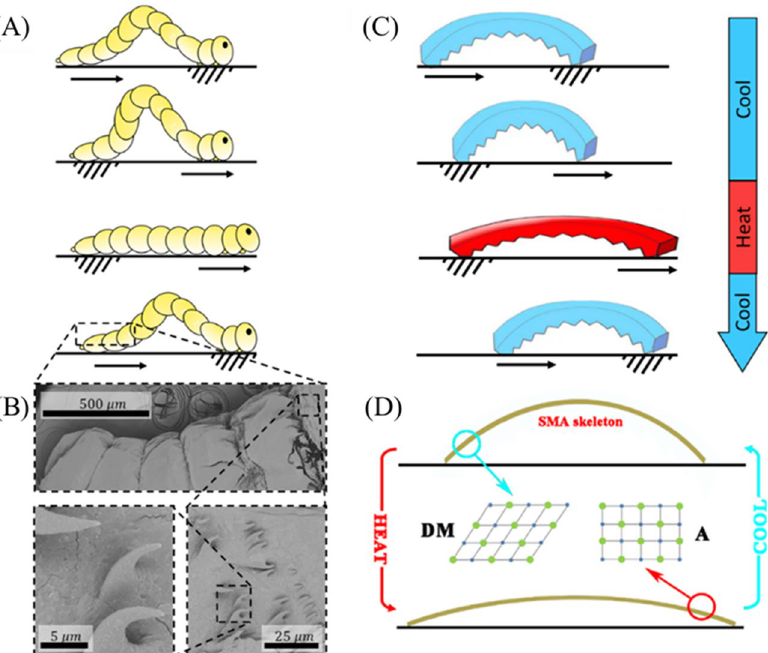
Figure 1. Schematic diagram of mag-bot. ( A ) A schematic of fruit fly larva movement displays the phases of peristaltic motion in which a larva anchors its head, pulls its tail towards its head, anchors hind portions of its body, and then pushes its head forwards. In many organisms 13,17 , such waves propagate non-harmonically along the creatures’ lengths, however—for simplicity—this is not illustrated here. ( B ) Scanning electron microscopic images of the surface microstructure of fruit fly larvae display hook-like features that give rise to asymmetric friction. ( C ) A schematic of ideal, bio-inspired mag-bot motion is displayed under a cycle of heating and cooling. ( D ) A schematic of the SMA skeleton inside of a mag-bot illustrates the microstructural phase evolution within the alloy that drives mag-bot bending and extension as the microstructure alternates between detwinned martensite (DM) and austenite (A) phases. Movement in ( A,C ) is denoted by arrows while anchoring is denoted by